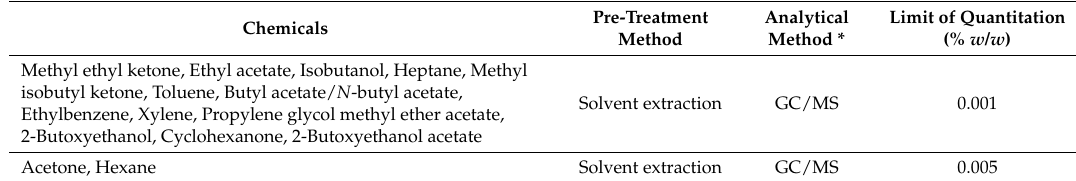
Table 1. The analytical method used for target